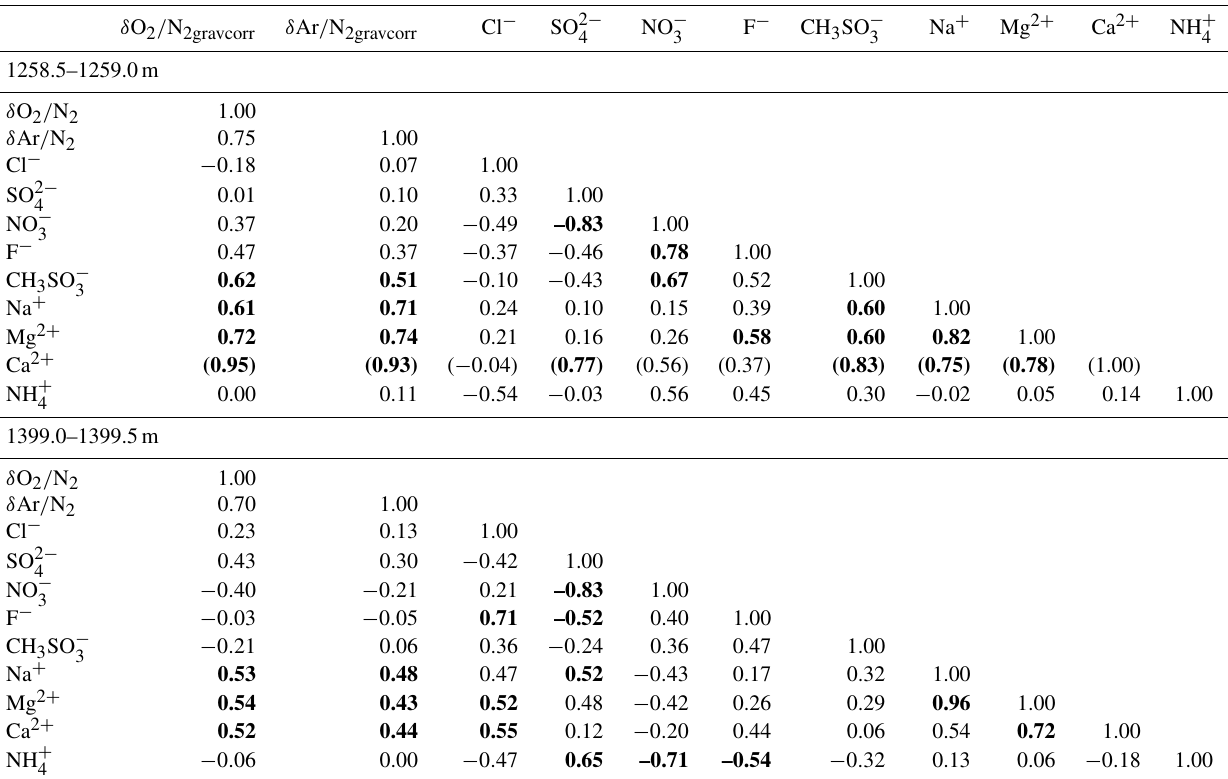
Table 1. Correlation coefficients between high-resolution gas data and ion concentrations within two 50cm samples. δ O 2 / N